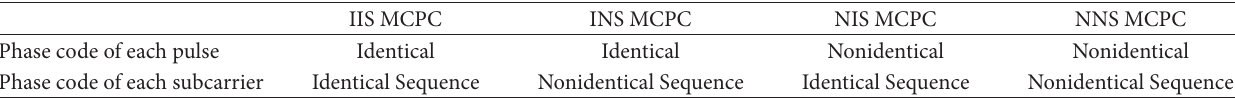
Table 1: Classification of MCPC pulse train signal.